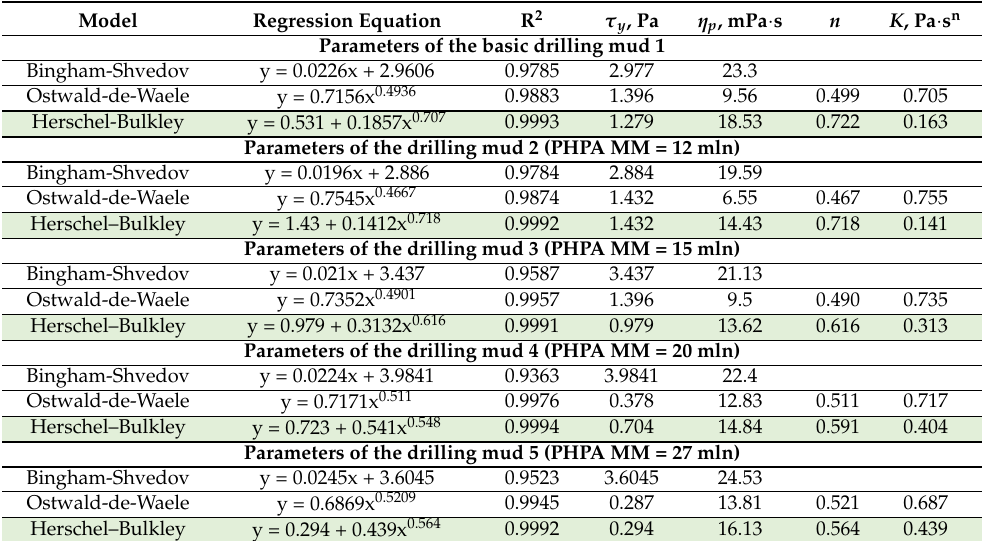
Figure 5. Selection of the rheological model for sample 4 with PHPA MM = 20 million ( a ) and for sample 5 with PHPA MM = 27 million ( b ).